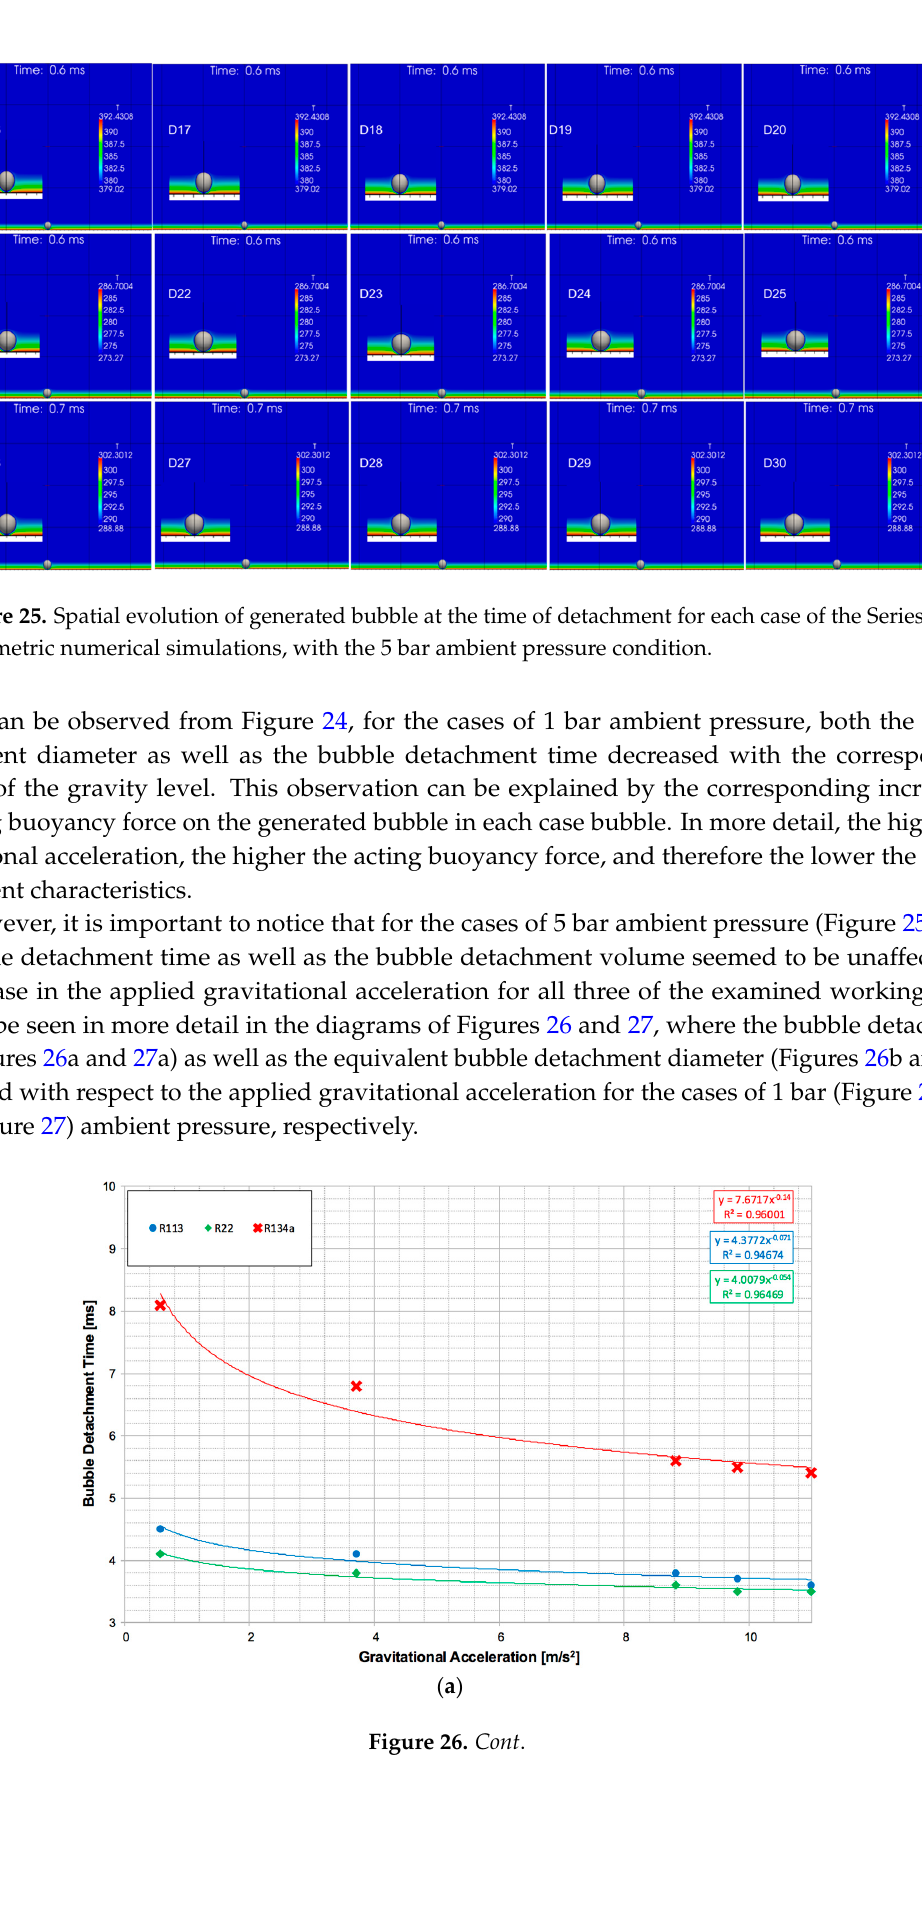
( b ) Figure 26. Effect of gravity level on: ( a ) the bubble detachment time; ( b ) the equivalent bubble detachment diameter (cases D1–D15, with the 1 bar ambient pressure condition).